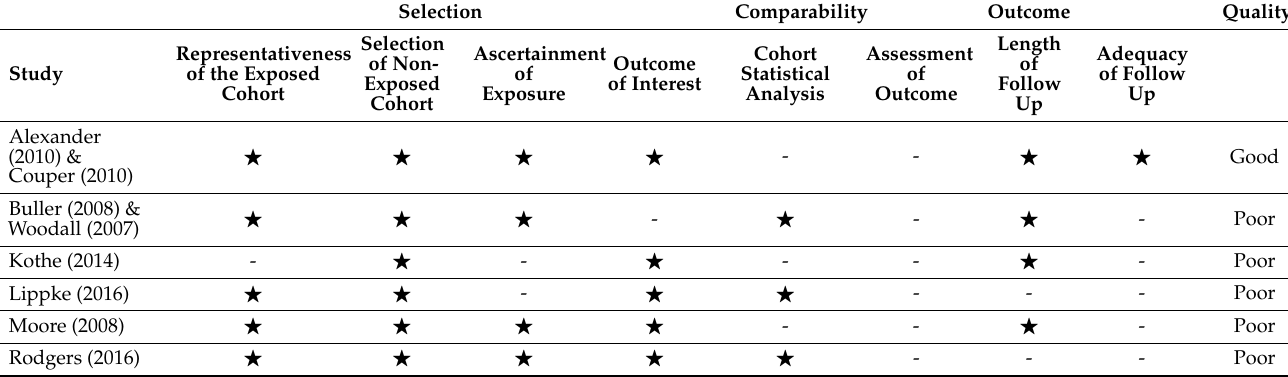
Table 2. Results of the critical appraisal of the included studies using the Newcastle—Ottawa Scale (a) for Cohort studies. Selection Comparability Outcome Quality Selection Representativeness Ascertainment of Non- of the Exposed of Study Exposed Cohort Exposure Cohort